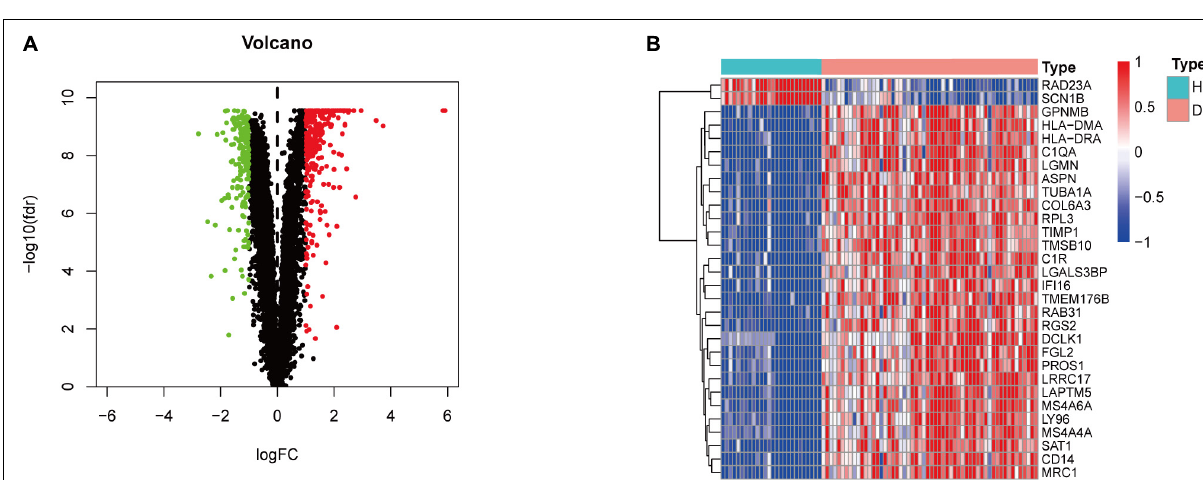
FIGURE 2 | Differential gene expression analysis. (A) Volcano plot representation of differentially expressed genes (DEGs) identified between DMD samples and normal samples. Red, green, and black plots indicate upregulated, downregulated, and non-significant genes, respectively, where the ordinate is -log10 (FDR) and the abscissa is logFC. (B) Heat map based on the first 30 DEGs. Red rectangles indicate high expression while green rectangles indicate low